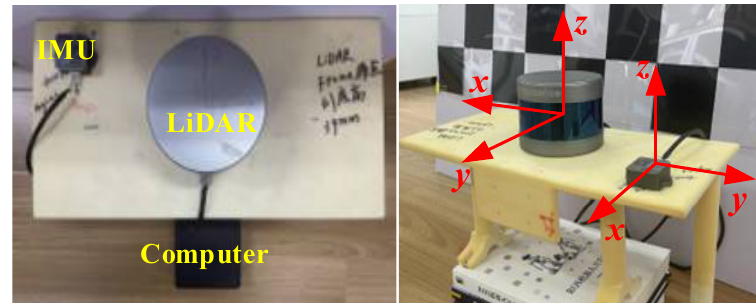
Figure 9. Physical map of IMU and LiDAR assembly.